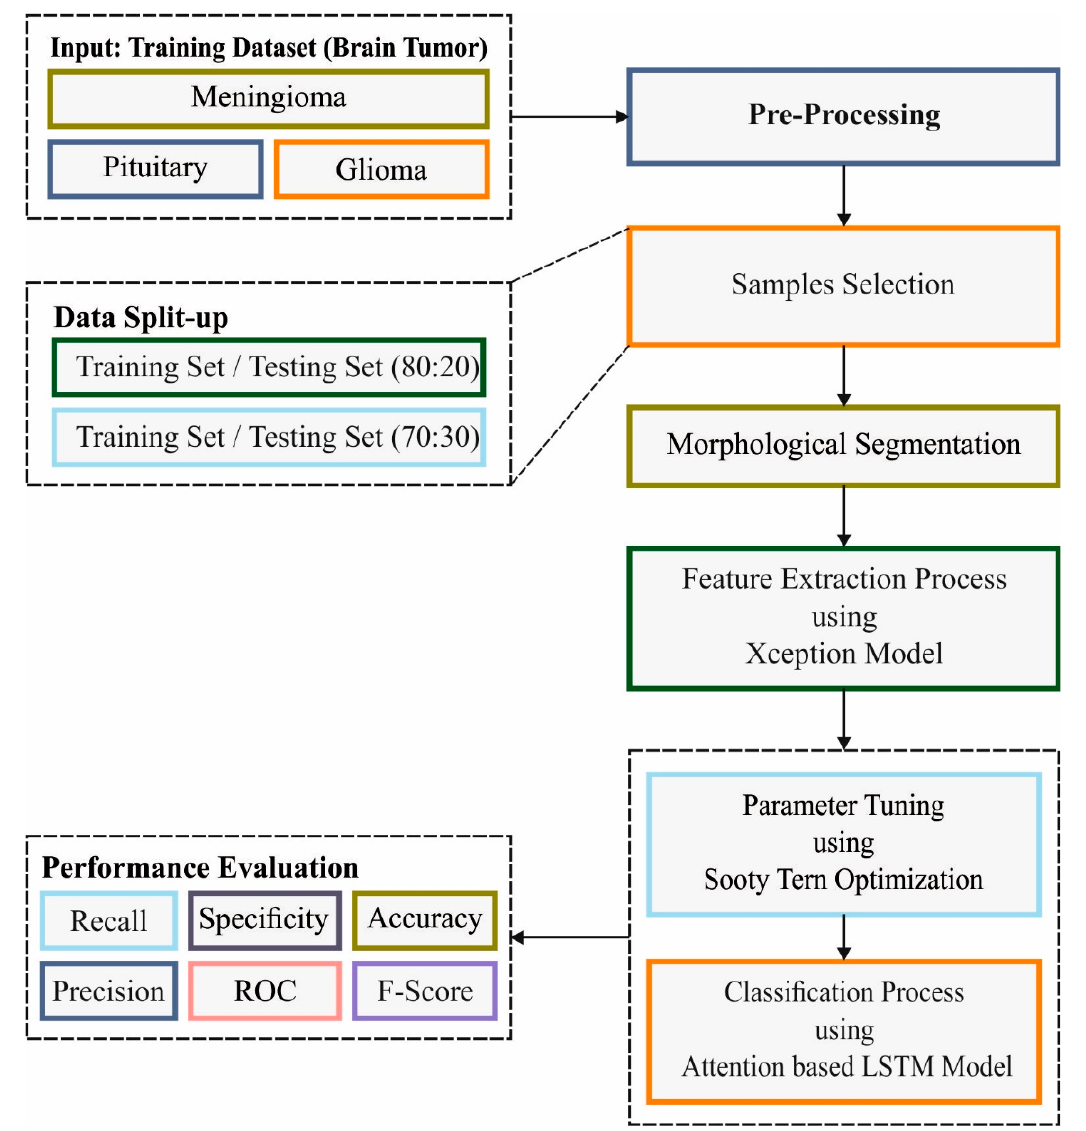
Figure 1. Overall process of EADL-BTMIC technique.